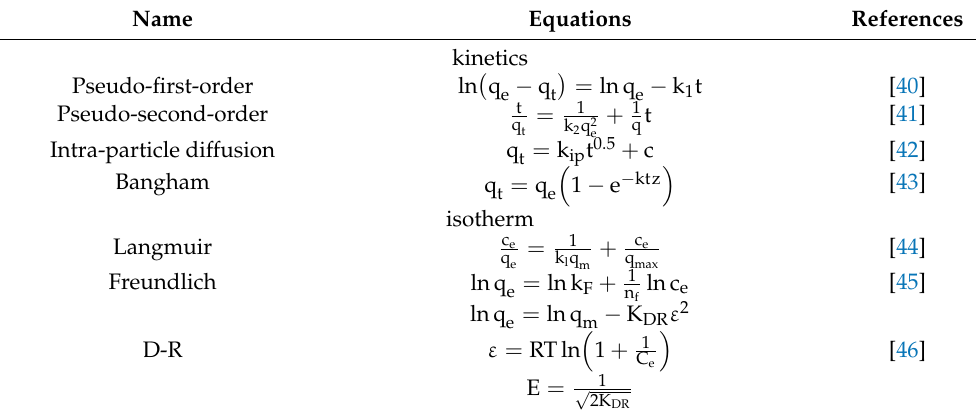
Table A1. Adsorption kinetic and isotherm models used in this study.